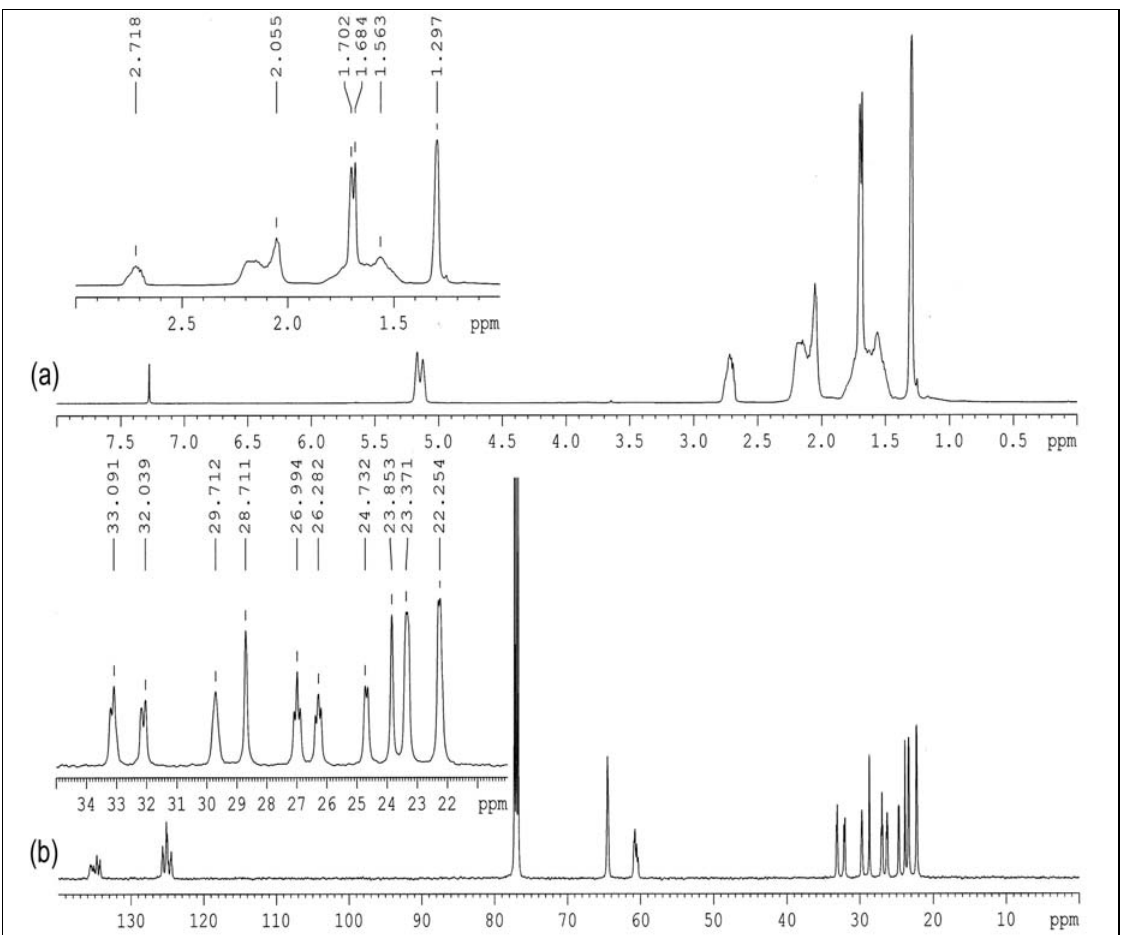
Figure 3. JRES spectra of purified ENR-50 (in CDCl